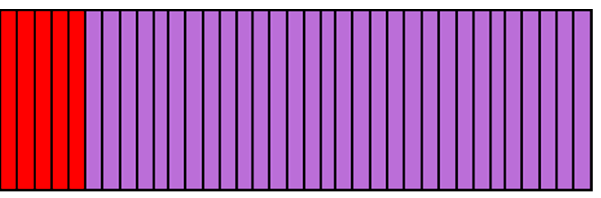
Figure 6. A representation of the solution to a hypothetical 30-mod problem with reactor modules (red) and membrane reactor modules (purple).